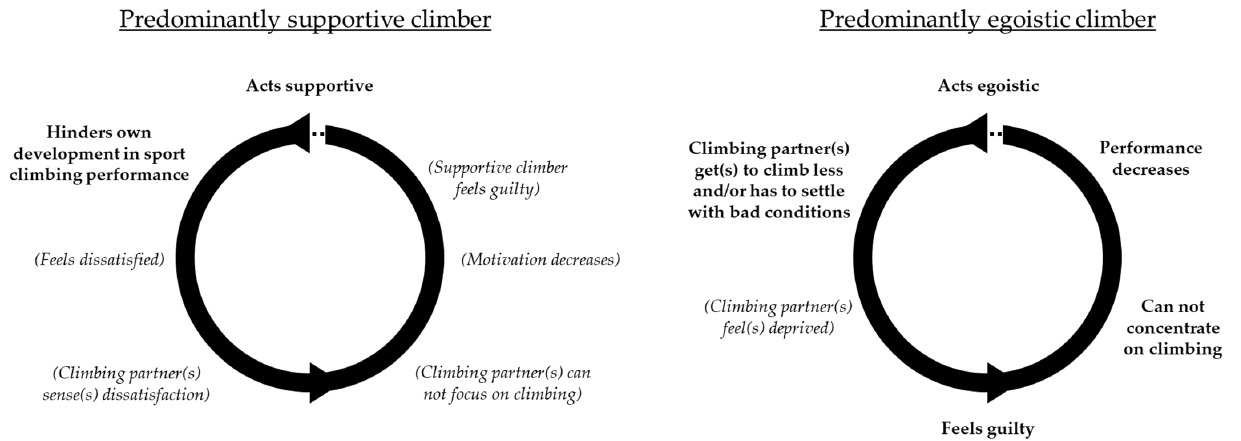
Figure 2. Negative effects of unbalanced behaviour. Scenarios for predominantly supportive or egoistic behaviour based on the participants’ experiences. The effects can be repetitive and self-amplifying. In most cases, one full circle describes one climbing session.